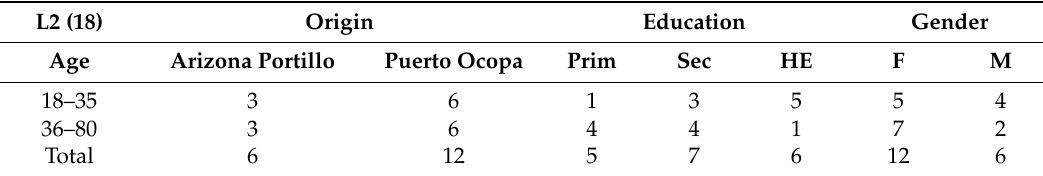
Table 2. Advanced L2 Spanish speakers by age, location, education, and